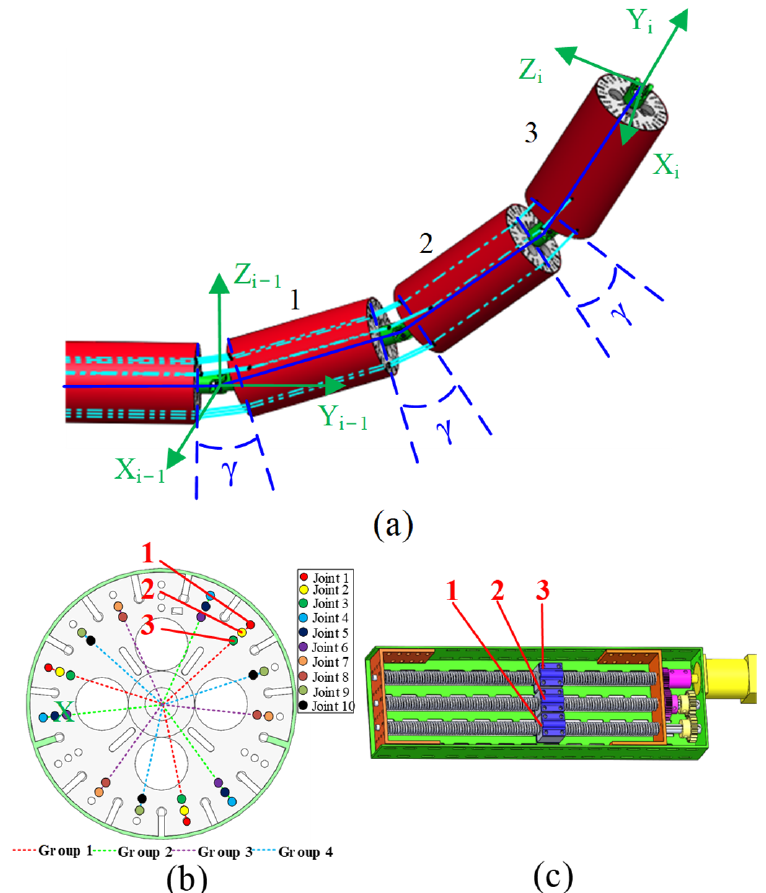
Figure 3. SAM underactuated mechanism and cable distribution. ( a ) Synchronous movement of the underactuated joint group rotation angle. ( b ) Distribution of traction cables for each joint. ( c ) The screw-rod module containing three screw rods moves in a ratio of 1 : 2 : 3 through the gear set. To highlight the novelty of underactuated SAMs, we compared the snake arm parame- ters produced by OC robotics and SIASUN robotics, as shown in Table 1. The following advantages can be achieved: (1) Under the premise of ensuring high spatial curvature and load capacity, the complexity of the drive system and control system is reduced by multiples. (2) The synchronous movement of adjacent joints considerably simplifies the kinematics model, and the inverse kinematics solution is more convenient and quicker. (3) A precise kinematics model can be established with high position accuracy. (4) The structural design can achieve miniaturization and lightweight, which are highly